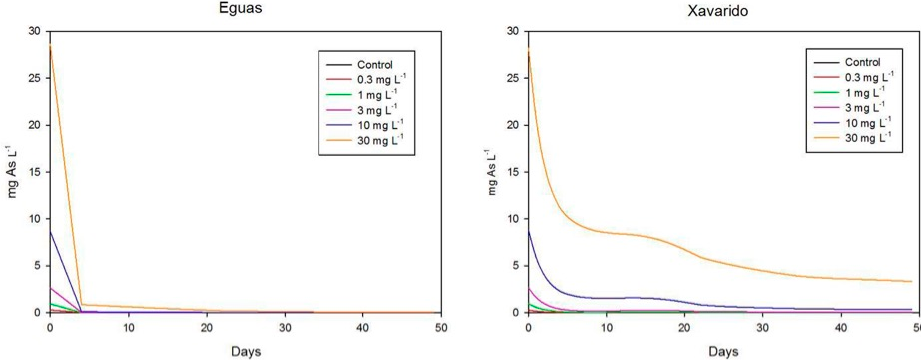
Figure 4. Evolution of total arsenic concentration in water during the first incubation experiment.